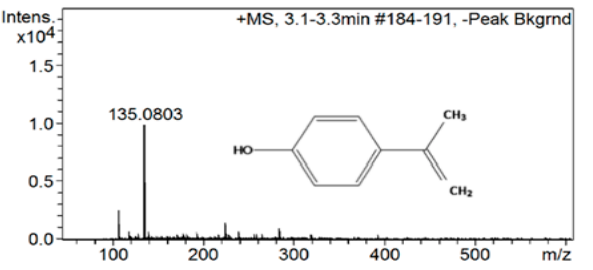
Figure 7. ESI-MS(+) for 4-isopropylphenol with molecular formula C 9 H 11 O ([M + H] + , m/z — 135.0803), mass range 50–600 m/z . The decomposition products of bisphenol A are shown in Figure 8.